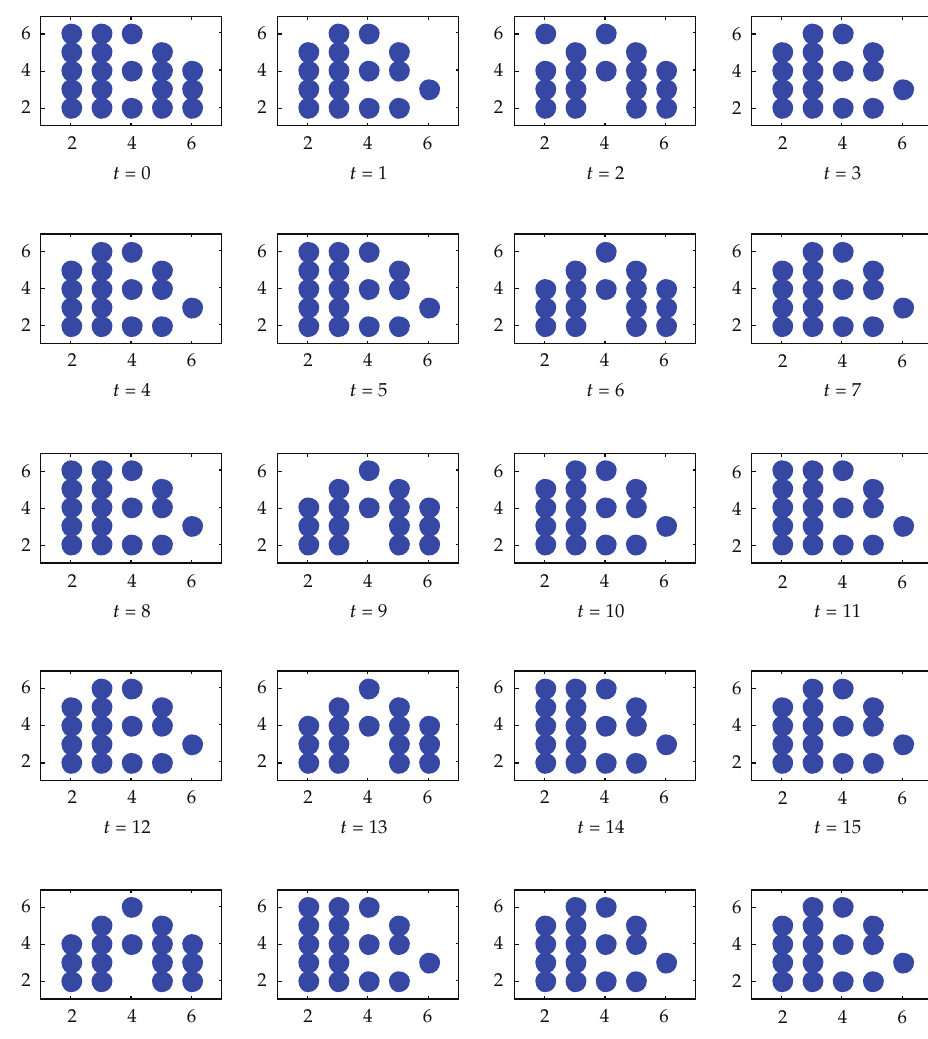
Figure 8: Output of a MCNN for separation of superimposed